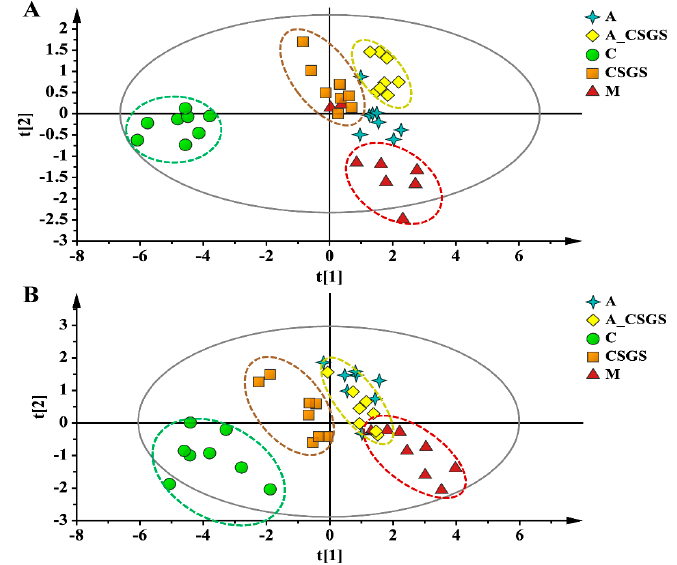
Figure 4. PCA score plot of hippocampus samples collected from different treatment groups of rats in (A, R 2 X = 0.761, Q 2 (cum) = 0.543) positive and (B, R 2 X = 0.831, Q 2 (cum) = 0.521) negative ion mode. C: control group; M: CVS model group; A: Antibiotic treated group with CVS; CSGS: CSGS treated group; A_CSGS: Antibiotic + CSGS treated group.